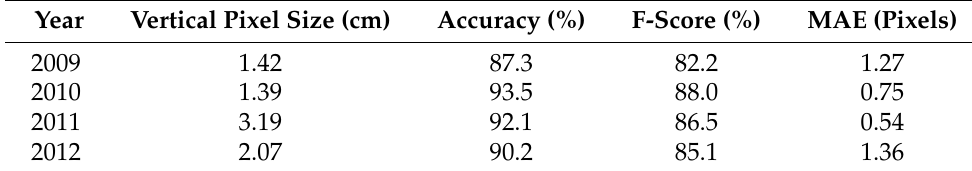
Table 5. Pixel size in the vertical (depth) direction, as well as the accuracy, F-score, and MAE, obtained over each year of EG.